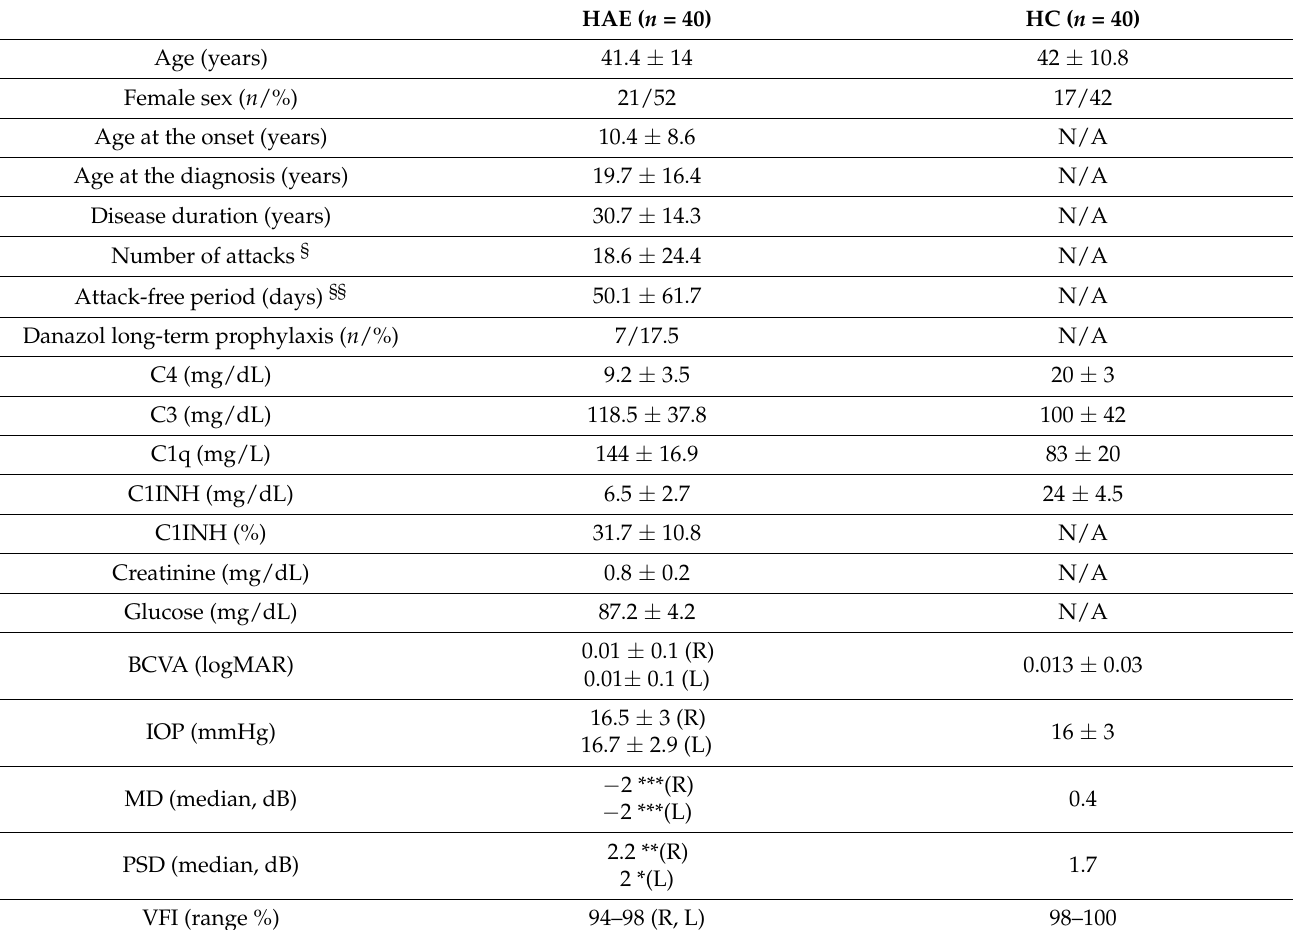
Table 1. Demographic and clinical parameters from the study